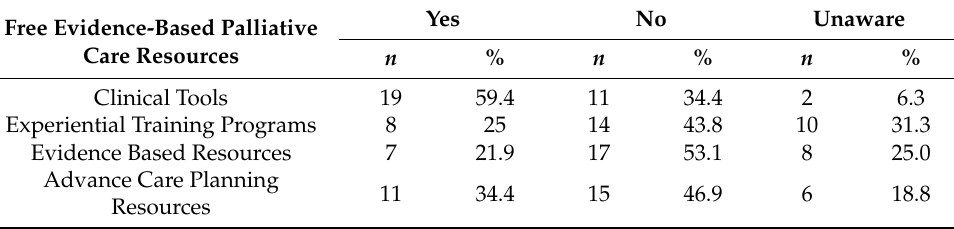
Table 5. Awareness of evidence based palliative care dosing and information resources.